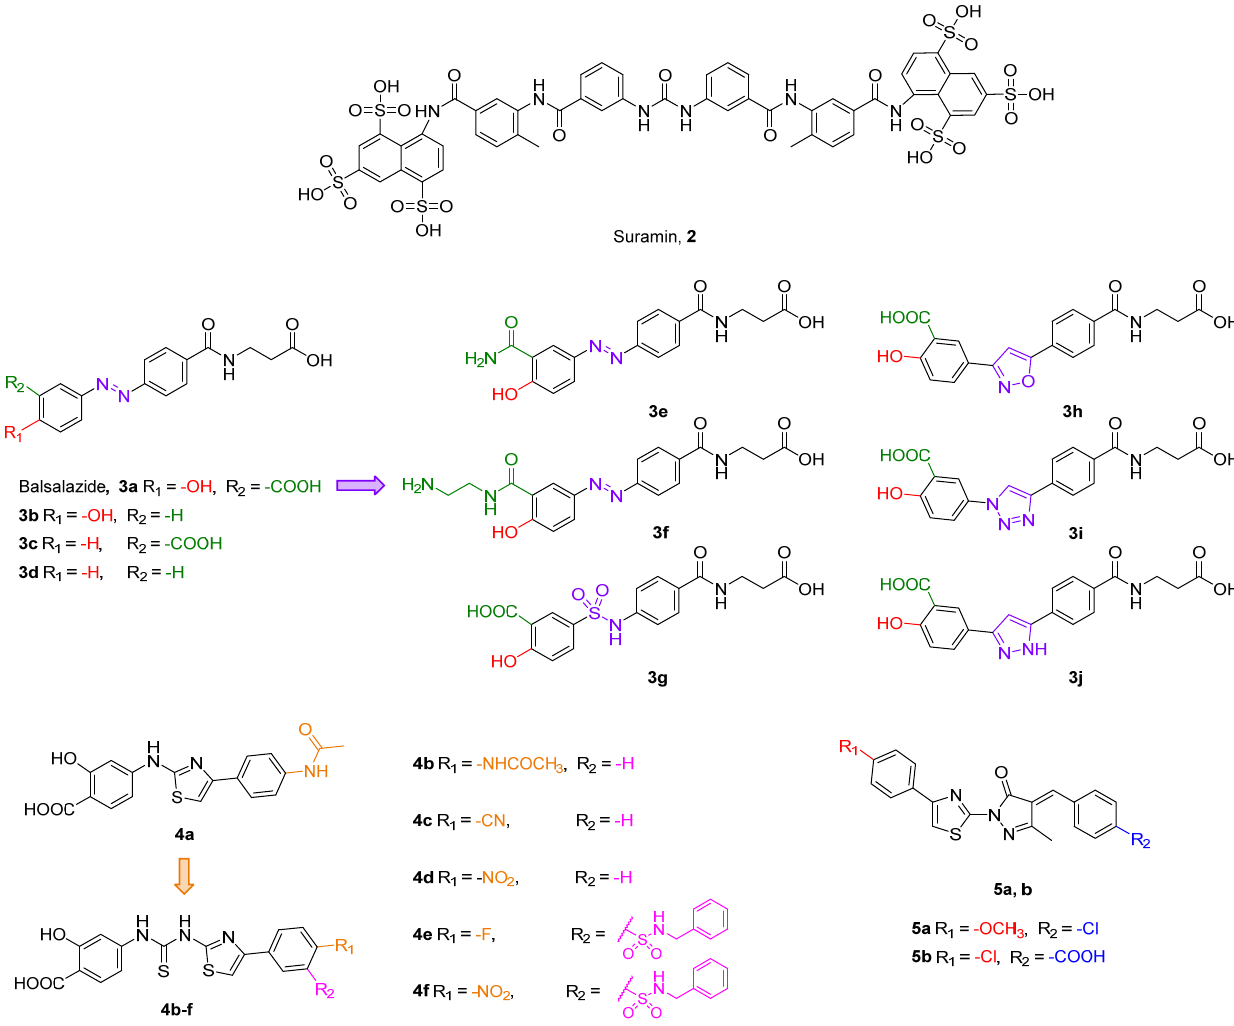
Figure 6. Structures of compounds 2 , 3a – j , 4a – f , and 5a , b